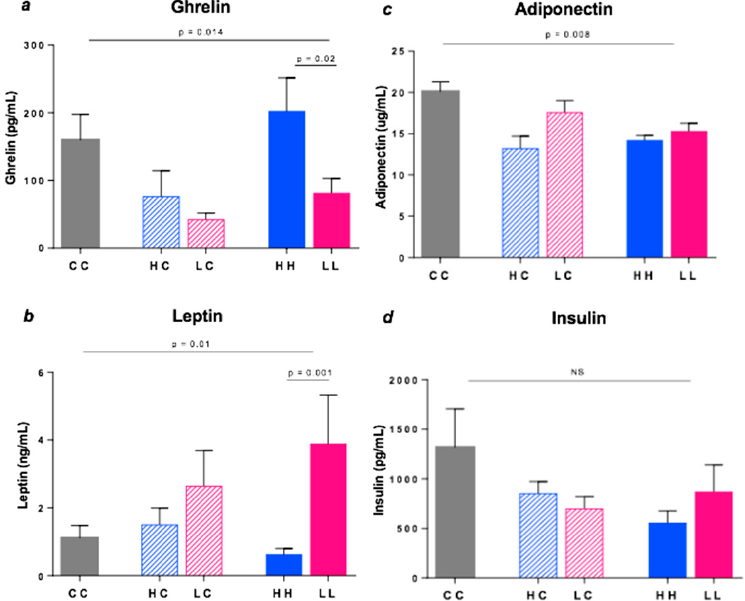
Figure 7. Plasma hormone levels in 20 week old mice ( a ) ghrelin, ( b ) leptin, ( c ) adiponectin and ( d ) insulin. Data represent the Mean ± SEM. CC n = 6, HC n = 8, HH n = 8, LC n = 8, LL n = 8. NS = not significant.